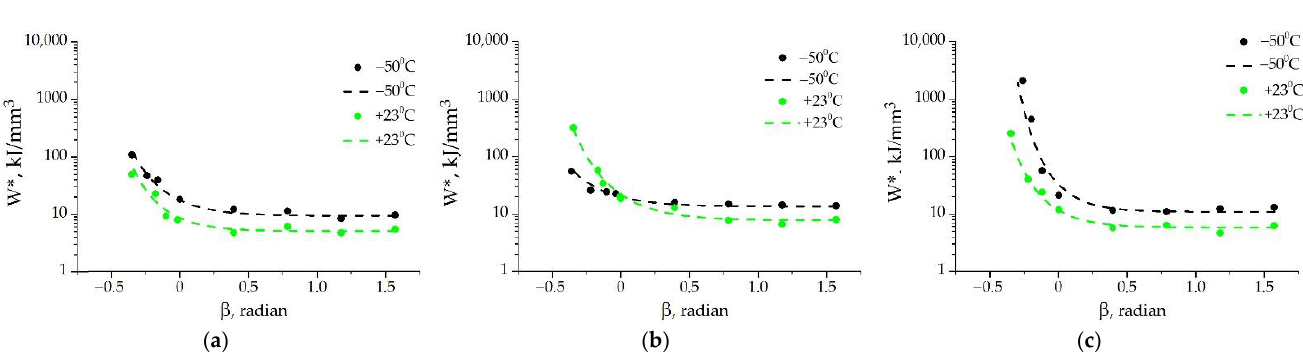
Figure 7. The fracture loci W *( β ) of the adhesive joints with A1 ( a ), A2 ( b ), and A3 ( c ): dots — exper- imental data, dashed lines — approximation by Equation (9).